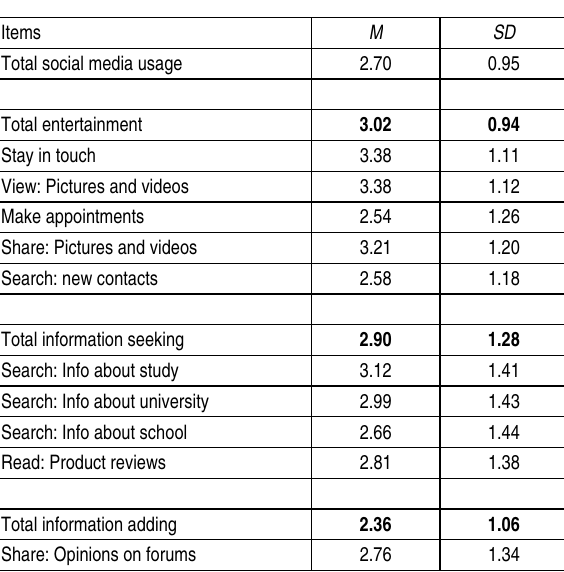
Table 2. Social media usage – descriptive statistics